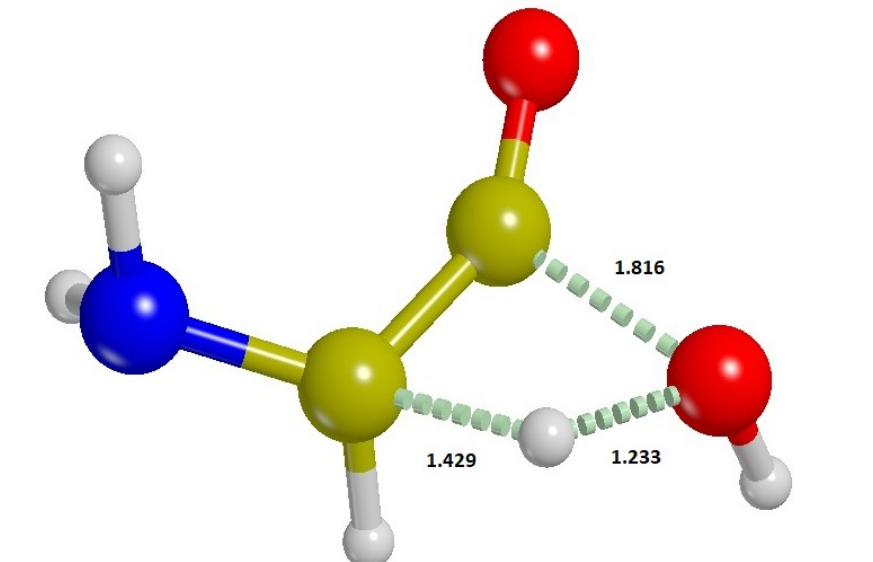
Figure 9. Transition structure for the elimination of water from glycine. The potential energy barrier at the B3LYP/6-31G(d,p) level of theory is 78.10 kcal mol − 1 . The corresponding barrier for the reverse reaction, the addition of water to aminoketene, is 29.42 kcal mol − 1 . Geometries are fully optimized, and distances are in